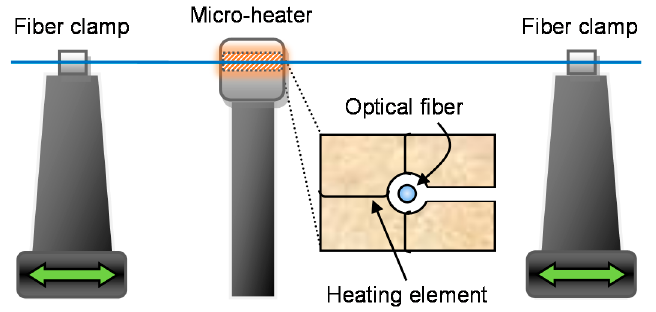
Figure 2. Schematic diagram of the modified flame-brushing technique.